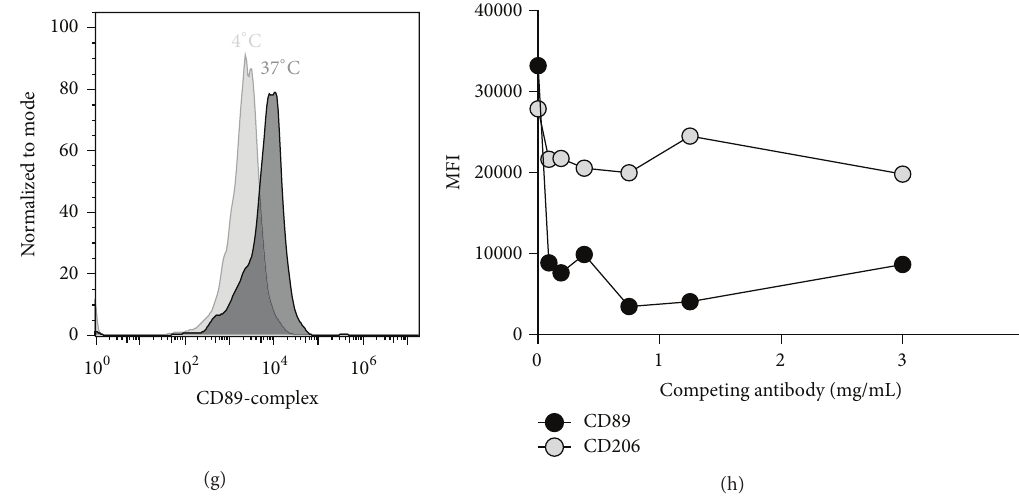
Figure 2: CD89 antibody and HLA-A2 complexes are efficiently bound and taken up by monocytes. (a) Diagram representing the targeting Ab. Positions of conjugated avidin groups depicted in the diagram are arbitrarily chosen. (b) Monocytes were stained with 1 𝜇 g/mL avidin conjugated (CD89-A (grey)) or nonconjugated (CD89 (white with black outline)) Ab. Staining was visualized with a secondary APC-labeled Ab. (c) Formation of the CD89-A HLA-A2 immune-complex (CD89-A2) was confirmed by an ELISA conjugated or nonconjugated (CD89- A/CD89)Abwhichwerecoatedona96-wellplate.(d)Abcross-reactivitywastestedbyremovingHLA-A2fromthesystemandincubatingthe antibodies as was done in (c). Grey bars indicate CD89, and white bars are the avidinylated CD89 Ab (CD89-A). ((e) and (f)) To test whether avidinylation had an effect on receptor mediated endocytosis (RME) monocytes were incubated with either conjugated CD89 (CD89-A) or nonconjugated CD89 at 4 ∘ C (grey histograms) or at 37 ∘ C (white with dark outline histograms). After 2 h incubation CD89 on the cell surface was visualized with a secondary Ab. (g) Uptake was confirmed by formation of a complex with biotinylated-CD89 and HLA-A2 monomer incubated with APC-labeled streptavidine (CD89-A2-strep) at a ratio of 2: 2 :1, respectively. The complex was incubated for 24 h at 4 ∘ C (light grey) or 37 ∘ C (dark grey) in the presence of monocytes. Shown is one representative experiment. (h) To establish CD89 mediated uptake monocytes were cultured with CD89-A2-strep, in the presence of increasing amounts of competing CD89 Ab or MR. After overnight incubation, the APC fluorescence intensity was assessed by flow cytometry as a measure for uptake. Shown is one representative experiment.